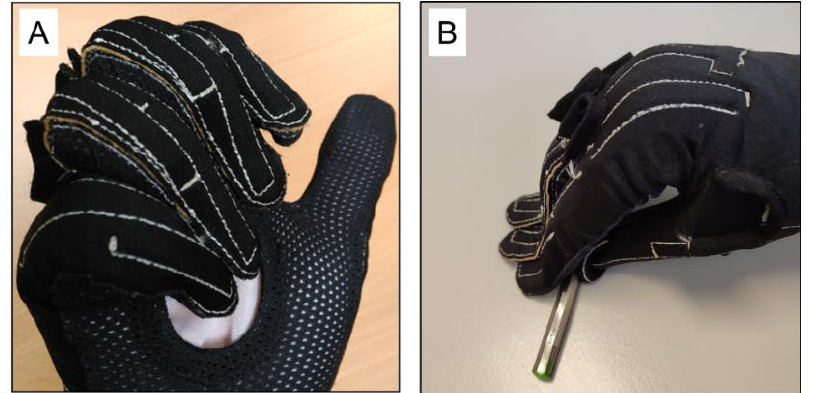
Figure 6. ( A ) PIP sensors spanning on PIPs and DIPs. ( B ) Fingertips hindering manipulation and bending.